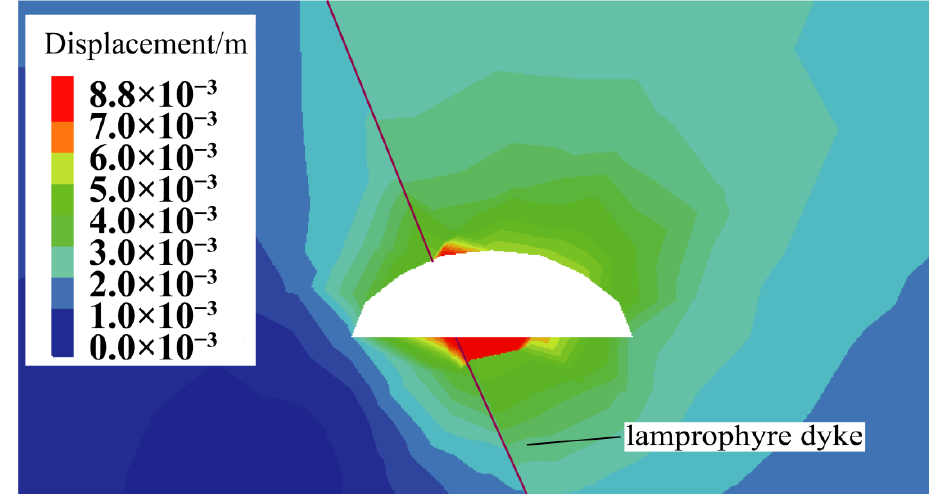
Figure 13. Displacement at the exposure of the lamprophyre dyke.